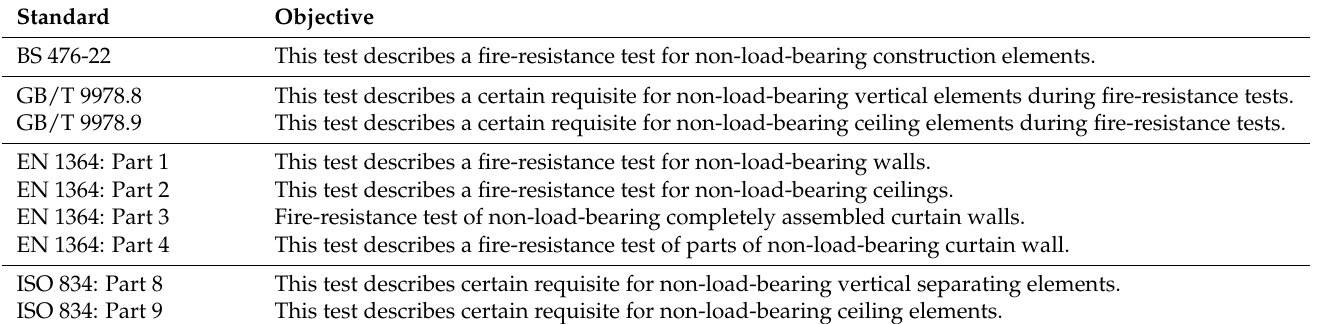
Table 4. Fire-resistance standards for non-load-bearing construction elements.